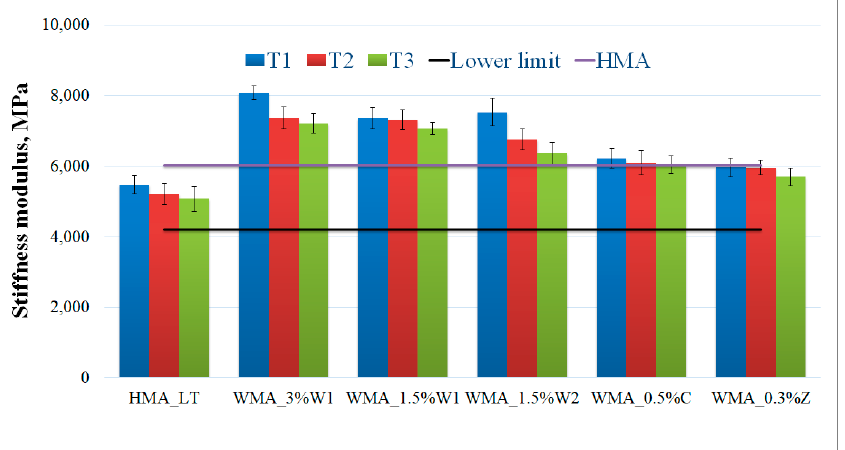
Figure 7. Stiffness modulus values for different asphalt mixtures (length of the error bar is equal to one standard deviation).